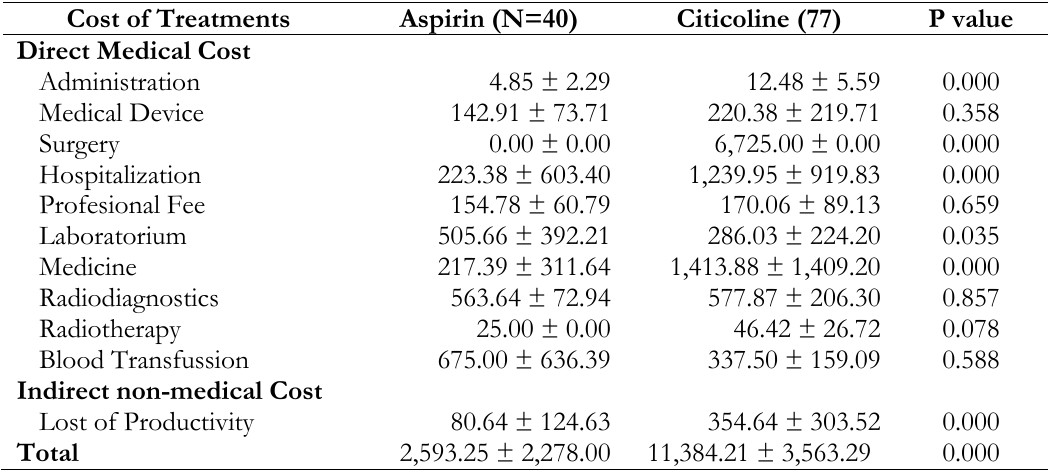
Table IV. Direct medical and indirect non-medical cost (Thousand Rupiah) in stroke patient at Prof Dr Margono